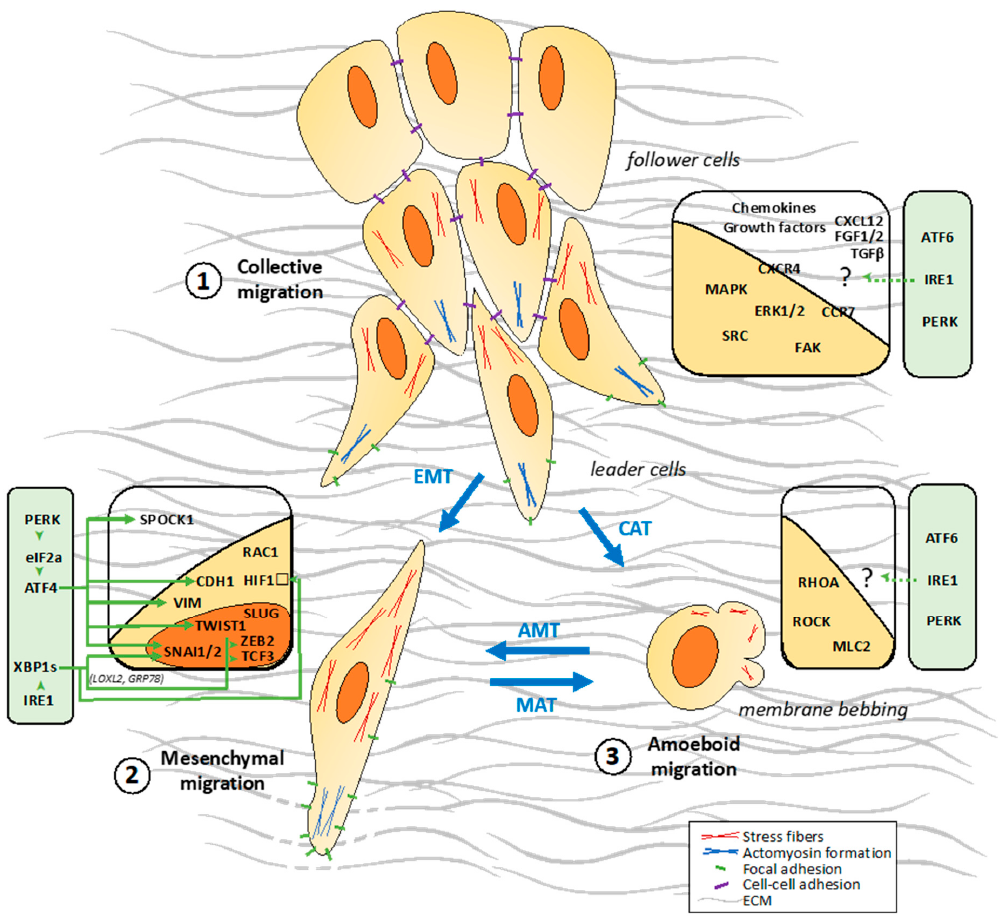
Figure 2. The migration modes used in cancer cell migration/invasion and their links to the UPR sensors